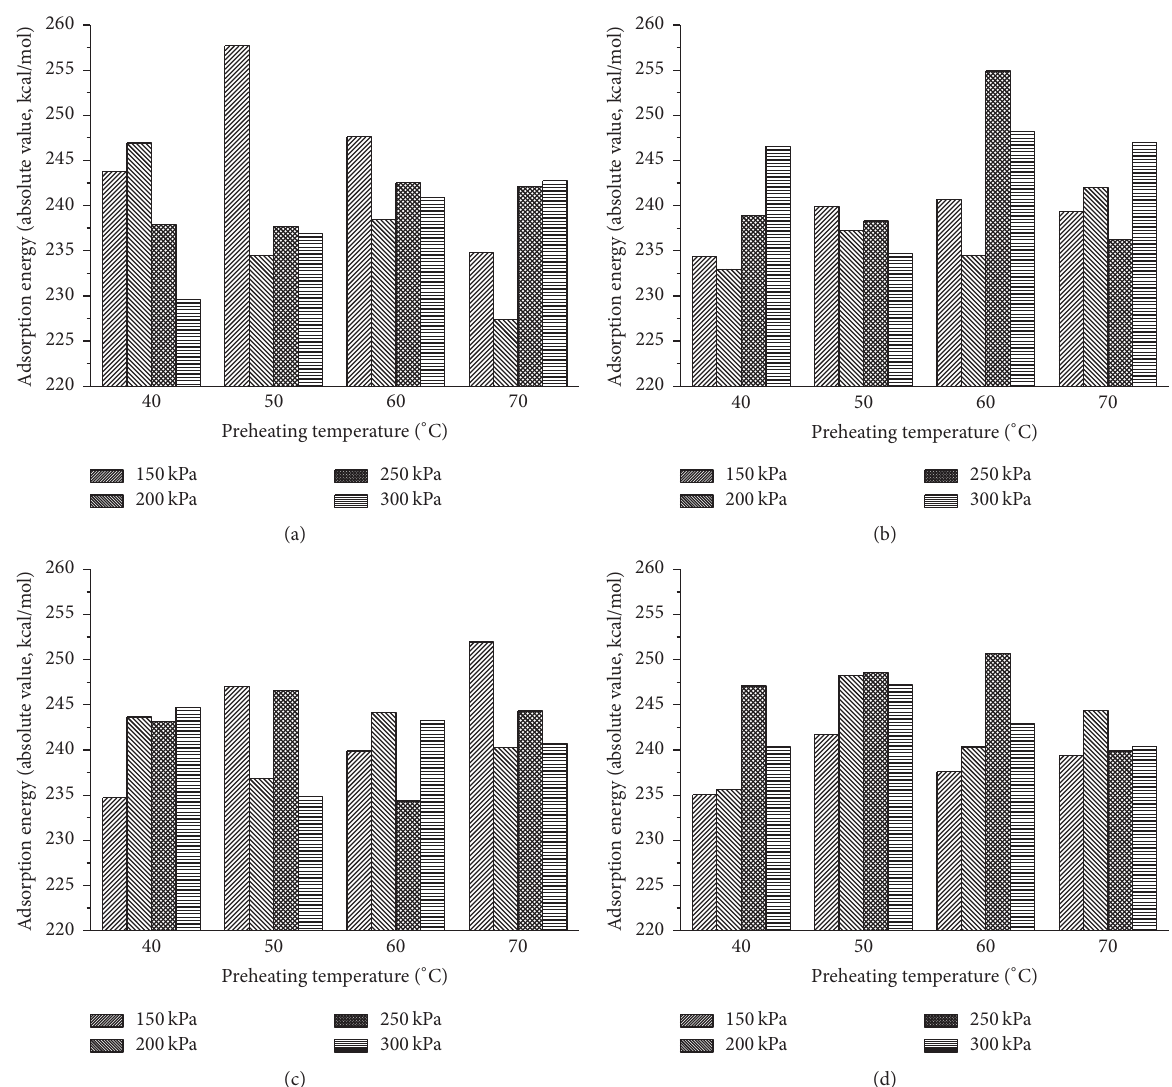
Figure 11: The absolute value of AE under the different processing parameters: (a) laying speed of 27 m/min; (b) laying speed of 30 m/min; (c) laying speed of 33 m/min; (d) laying speed of 36